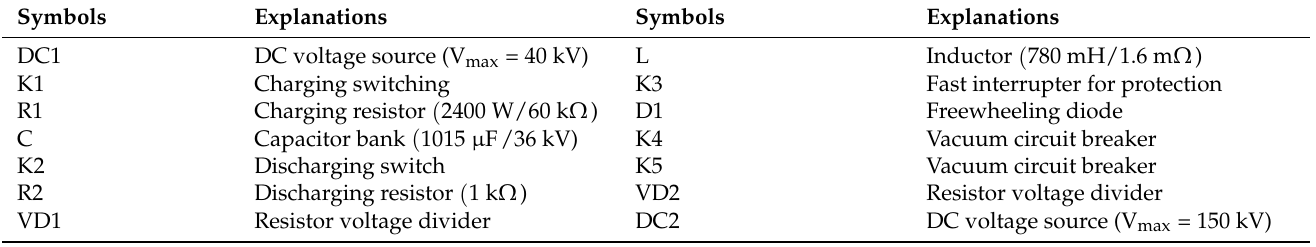
Figure 5. Schematic diagram of the test circuit with typical generated waveforms. Table 3. Explanations of the components in the test circuit.